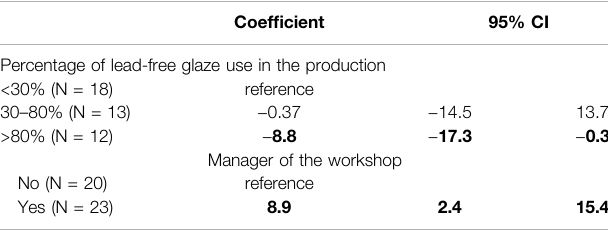
Bold values indicate p value <